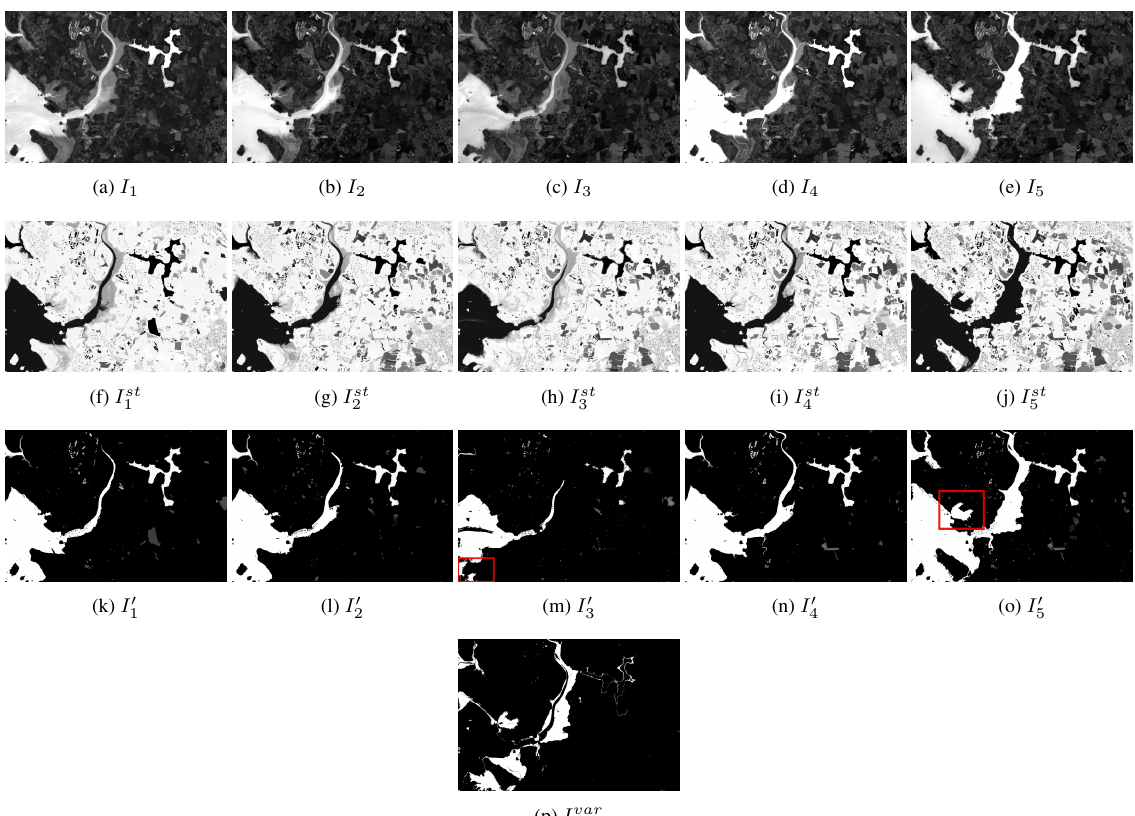
Figure 6. Intertidal Observation. a-e: Input Sentinel-2 NDWI images; f-j: Stability feature image for each time sample; k-o: Tide Observation for each time sample with our method; p: Tide observation with the pixelwise variation